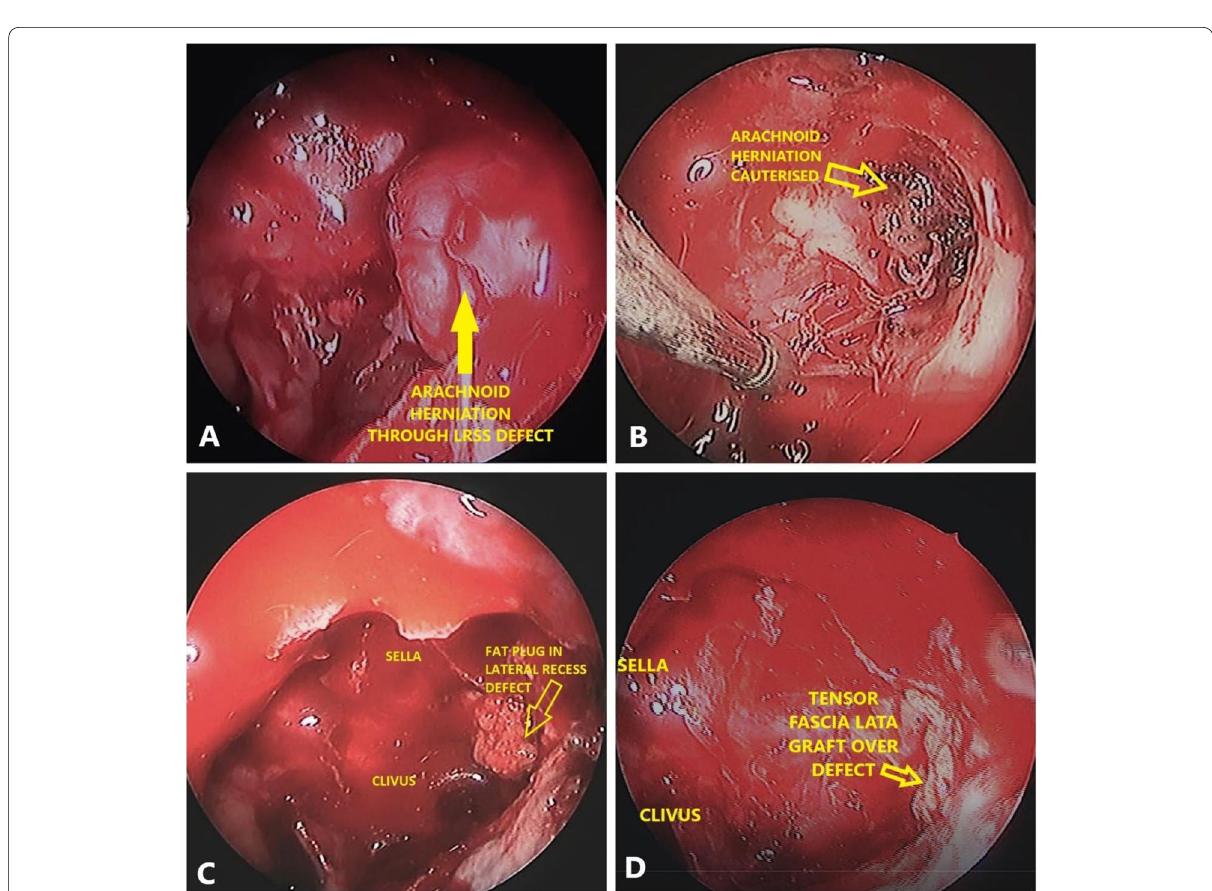
Fig. 3 Endoscopic images showing A arachnoid herniation through the left lateral recess of sphenoid defect, B arachnoid herniation after cauterization with bipolar cautery, C fat plug in the lateral recess defect, D tensor fascia lata placed over the fat plug in the